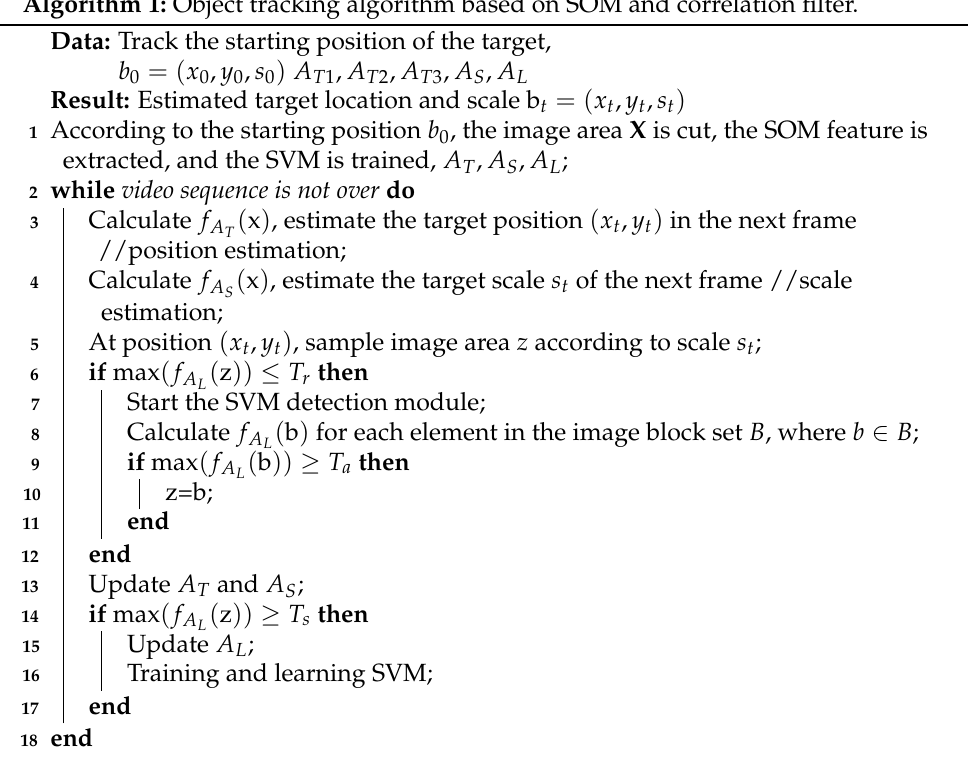
Algorithm 1: Object tracking algorithm based on SOM and correlation